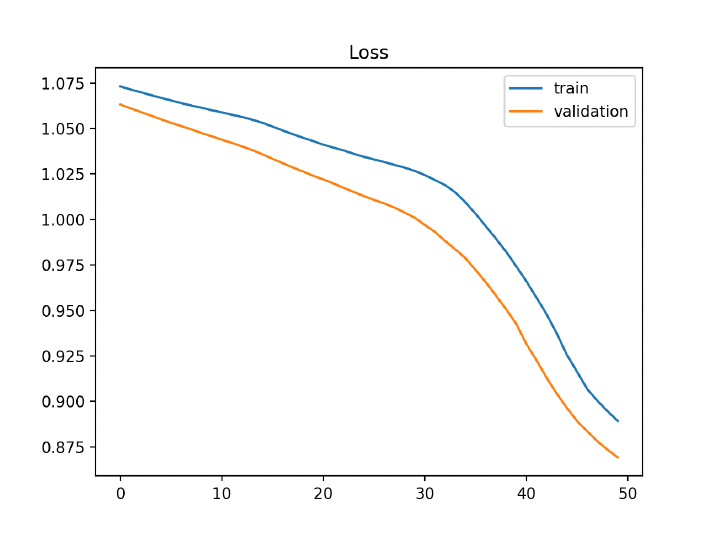
Fig. 3 The loss curve of the text detection